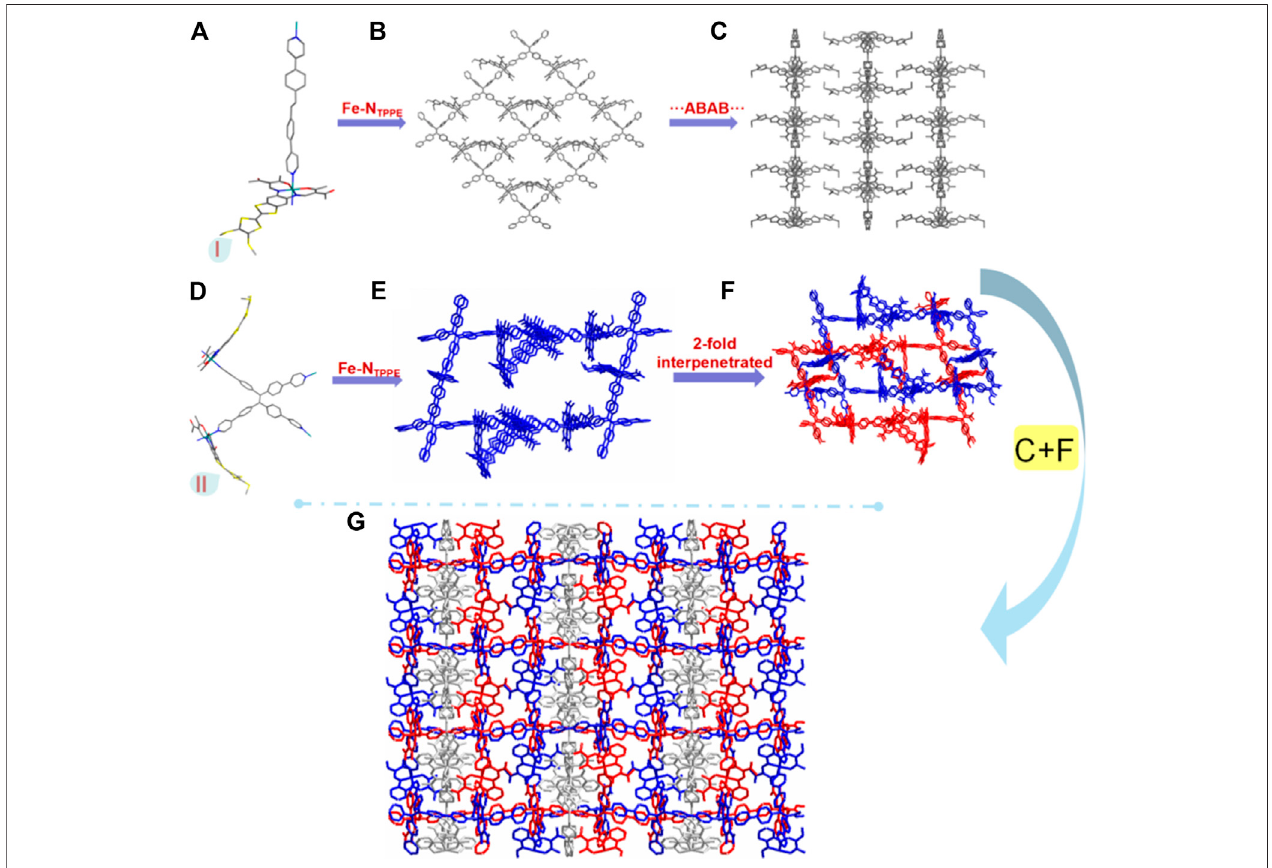
FIGURE2| MonomerI (A) ,a2DnetworkofmonomerI (B) ,thepacingstructureofa2DnetworkofmonomerI (C) ,monomerII (D) ,3Dframestructureofmonomer II (E) ,the2-fold interpenetrated of3Dframestructureofmonomer II (F) andthe3D interpenetrated frameworkincluding 2Dnetworkand 3Dcrystalstructurealongthe a axis (G) for 2 . All of the hydrogen atoms are omitted for clarity, carbon - grey, nitrogen -blue, oxygen - red, sulfur - yellow, iron - teal.